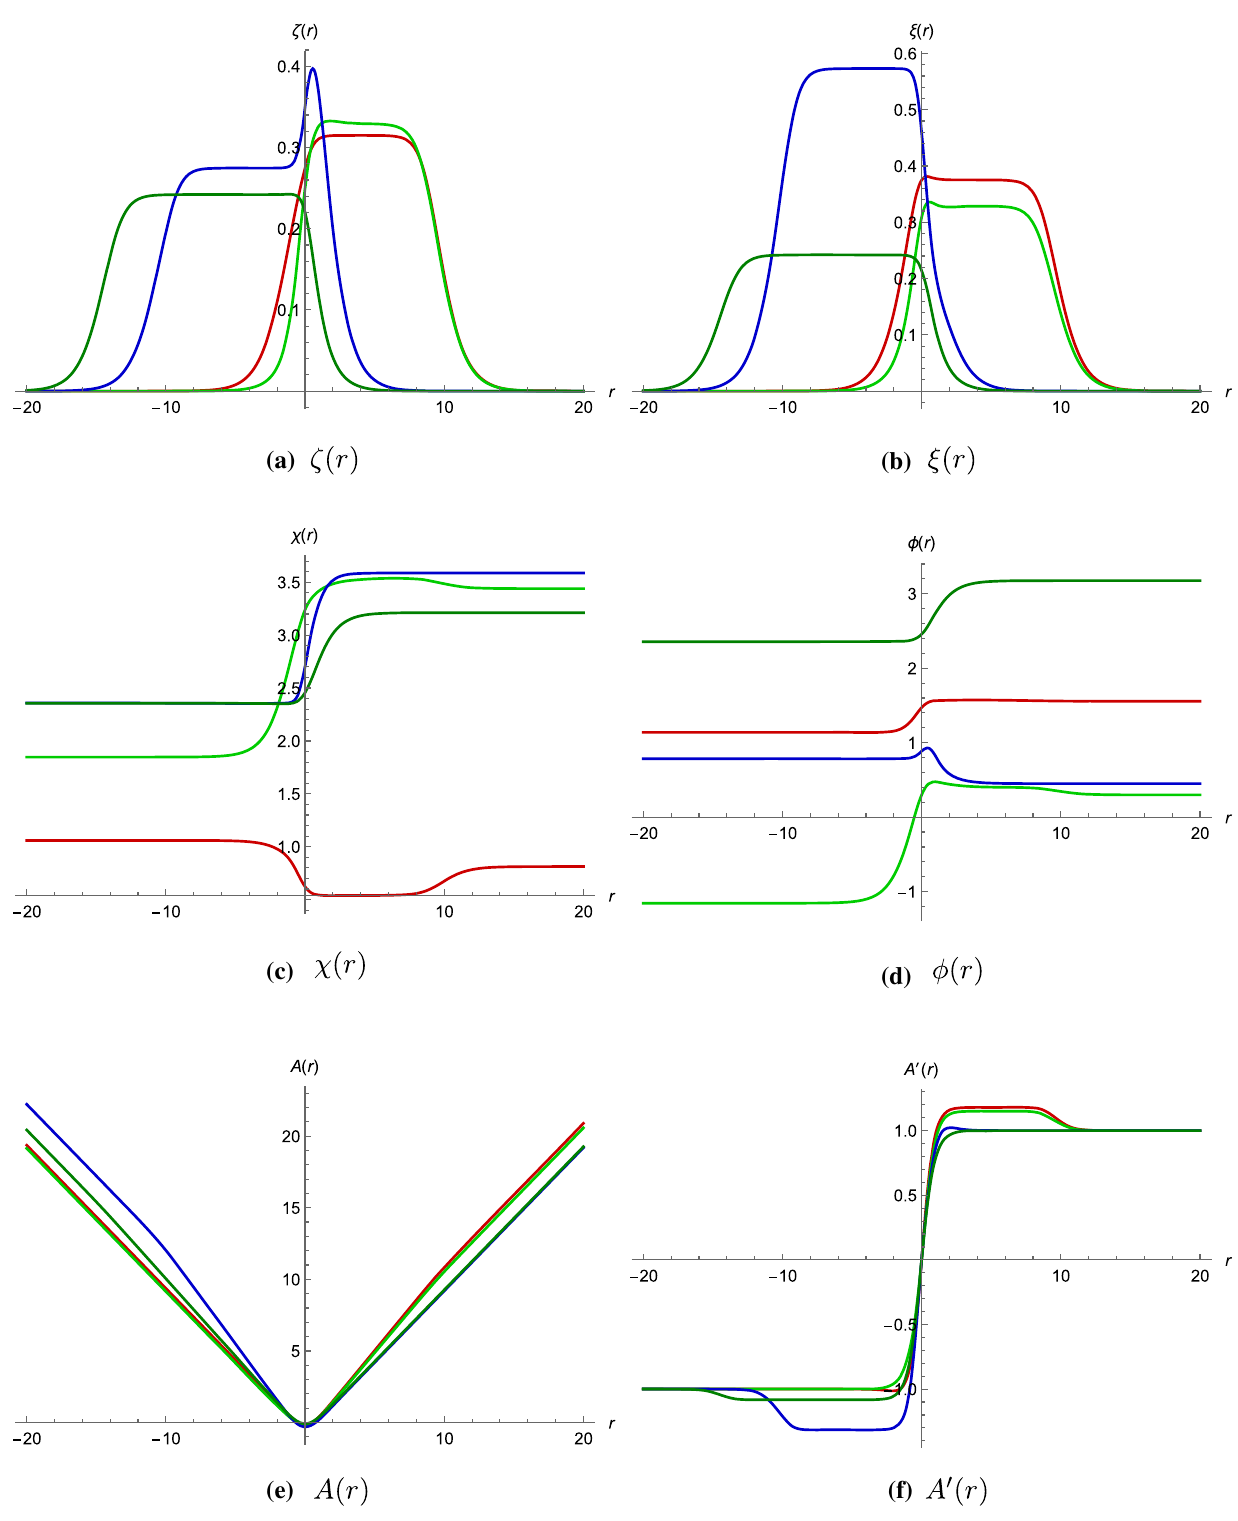
Fig. 12 Profiles of scalar fields (ζ,ξ,χ,φ) and the warped factor A for SO ( 8 )/ U ( 3 ) , SO ( 8 )/ G 2 , SO ( 8 )/ G 2 and SO ( 8 )/ SU ( 3 ) Janus solutions with ω = π as functions of the radial coordinate 8